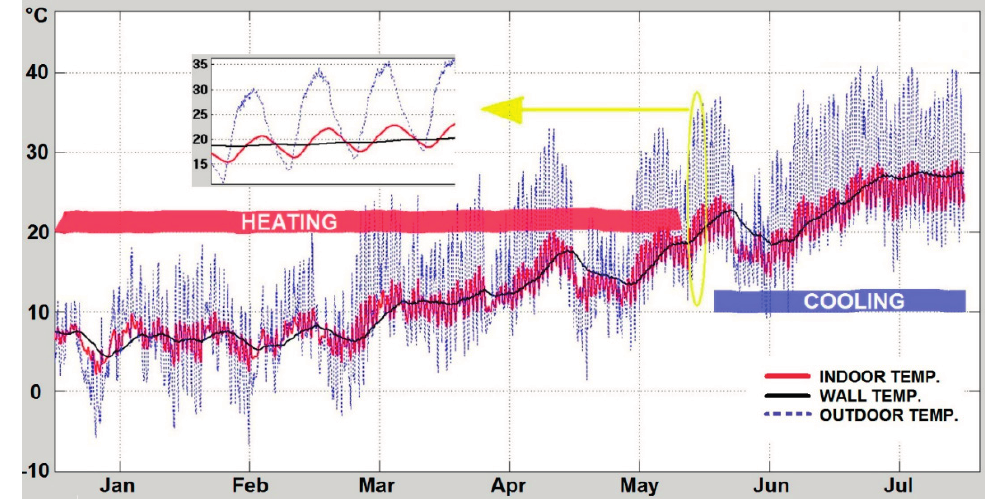
Figure 7. Thermal inertia, seasonal and daily temperatures. Outdoor measured temperature, and both indoor and wall simulated